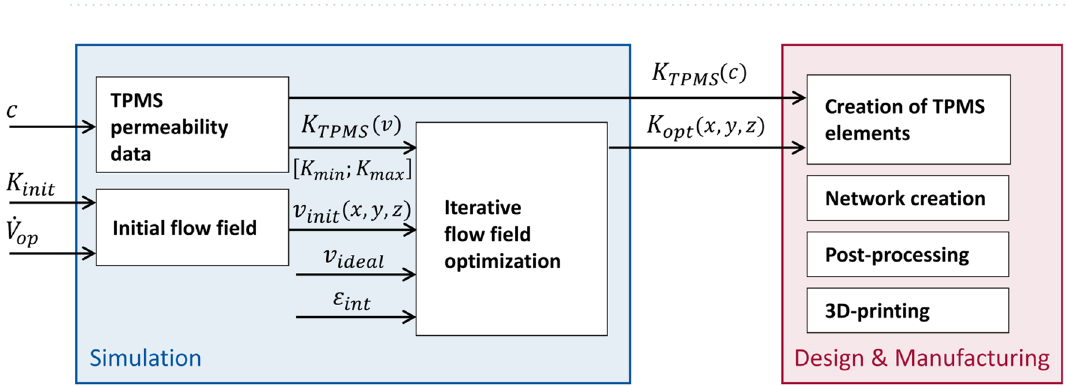
Figure 1. A iLA Membrane Ventilator used as predicate device in this study ( a ) Overview of the predicate device. Note the opposing inlet and outlet ( b ) cut-open predicate device (1) de-airing ports in the uppermost corner (2) antechambers (3) outlet (4) inlet [rectangles indicate postion of the magnified images in ( c ) and ( d )] ( c ) magnified side-view (5) distributor plate with equally spaced holes ( d ) magnified view of inlet–outlet section (6) distributor plates (7) hollow fiber bundle.